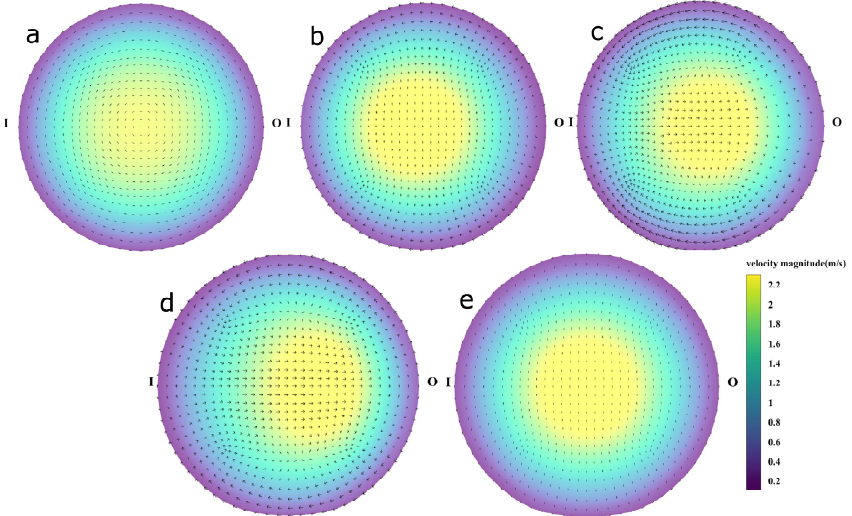
Figure 15. In the 90° channel at the conveying rate of 2.85 cm 3 /s, ( a – e ) are the profiles of the velocity magnitude and the velocity vectors on the five slices as indicated in Figure 2a.